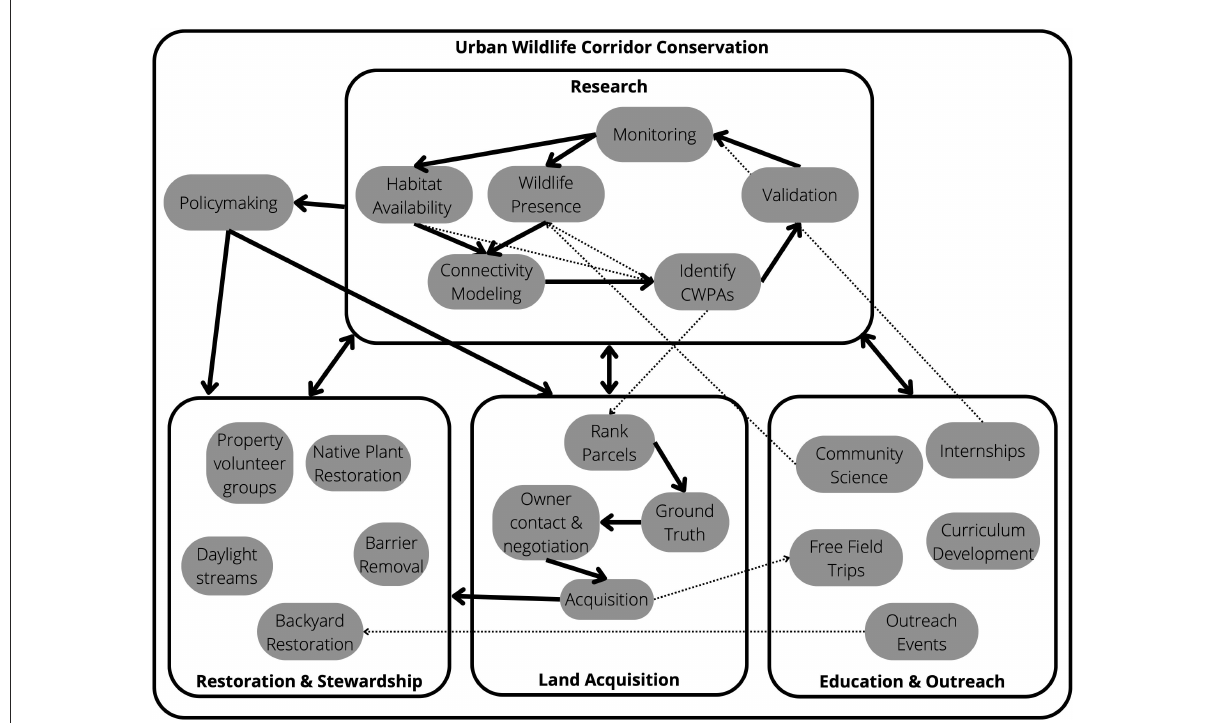
FIGURE3 Graphical abstract of urban wildlife corridor conservation strategy. Urban wildlife corridor conservation requires a multi-pronged, collaborative approach including research, land acquisitions, restoration and stewardship, and outreach and education. CWPAs refers to critical wildlife passage